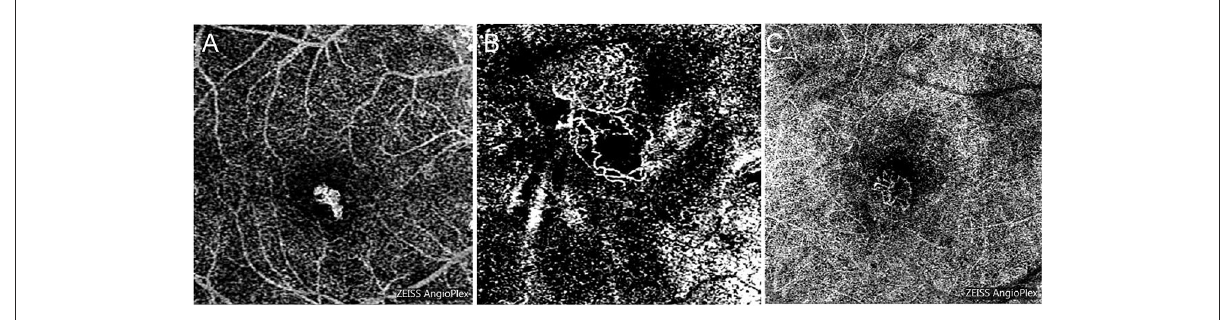
FIGURE5 The morphology of PM-CNV on optical coherence tomography angiography was shown as: “clumped” (A) , “medusa” (B) , and “sea-fan” (C) .